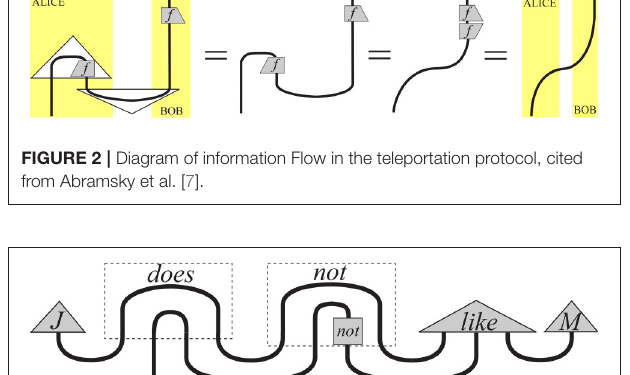
Frontiers in Physics |